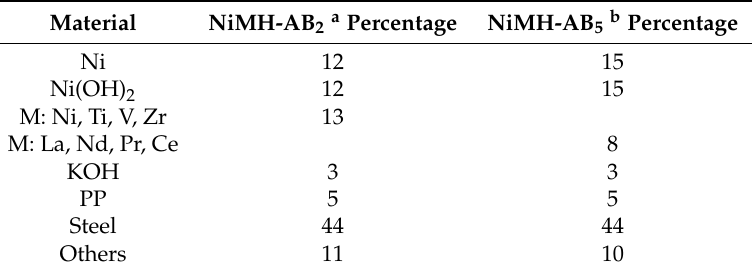
Table 6. Composition (by weight percentage) of two leading Ni-MH batteries [104].